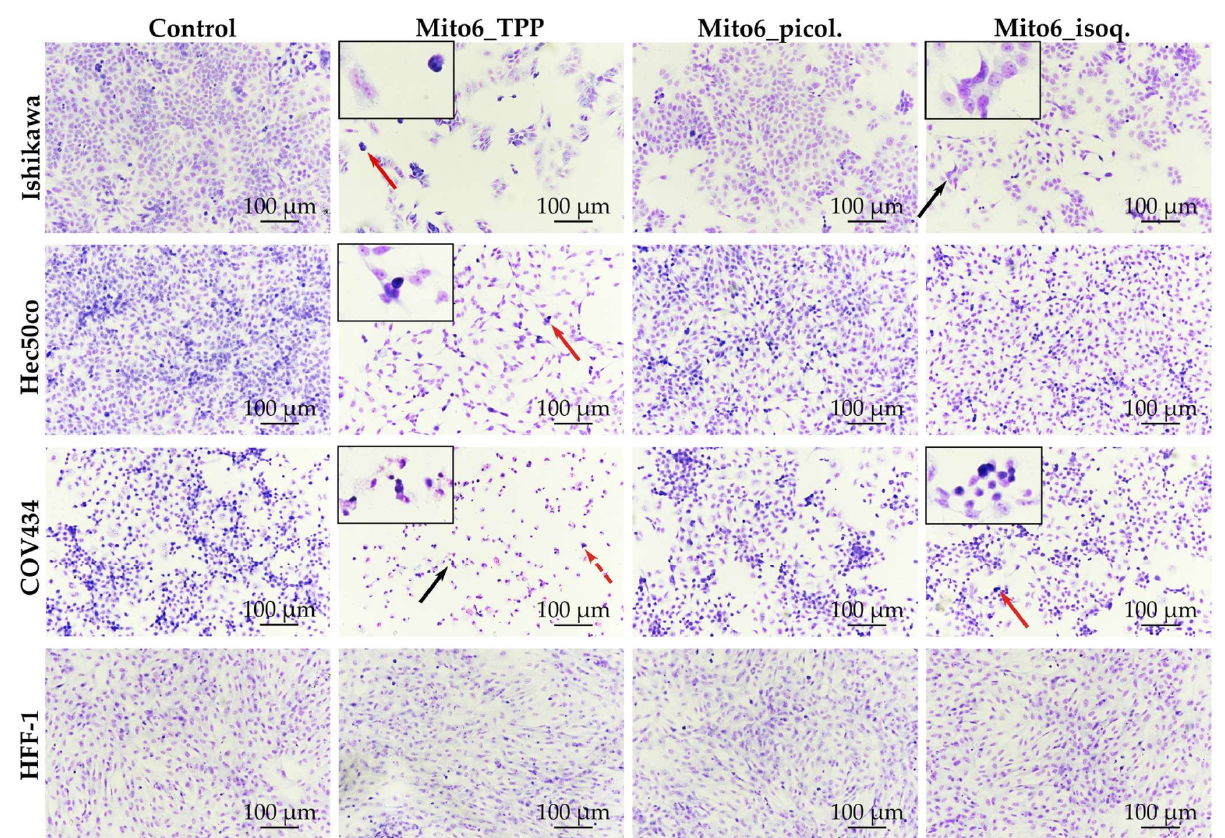
Figure 5. Cell morphology assessed by Giemsa staining of Ishikawa, Hec50co, COV434, and HFF-1 cells after incubation with 5 µ M of Mito6_TPP, 20 µ M of Mito6_picol., or 10 µ M of Mito6_isoq. Untreated cells containing only the respective cell medium and 2% FBS were used as control. The results presented are representative of at least three independent experiments. Black arrows indicate examples of abnormal cell morphology and red arrows indicate examples of chromatin condensation. The black boxes contain higher magnification images containing the cell morphology or chromatin condensation indicated by the full arrows. The traced arrows are not in the enlarged